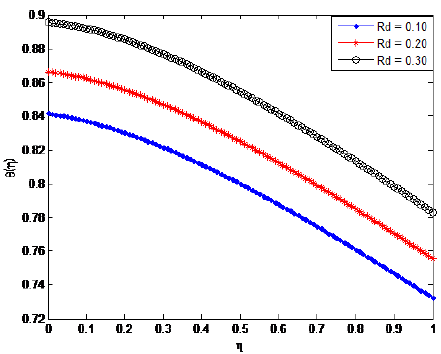
Figure 6. Influence of Radiation term on dimensionless temperature profile